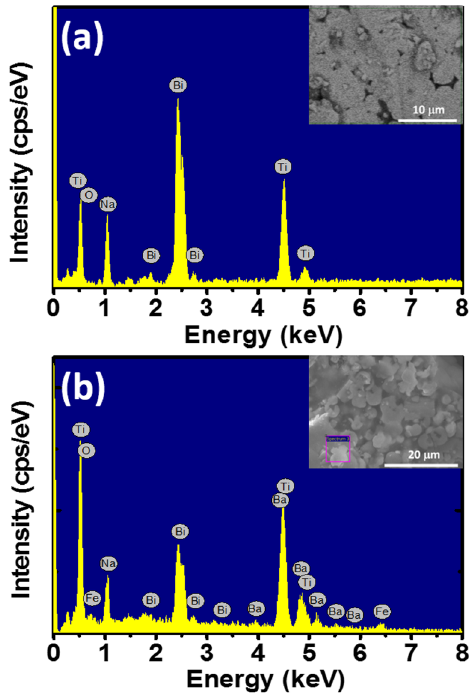
Figure 1. The EDS spectral of (a) pure Na 0.5 Bi 0.5 TiO 3 materials, and (b) BaFeO 3− δ -modified Na 0.5 Bi 0.5 TiO 3 materials with 5 mol% BaFeO 3−δ as solid solution. The inset of each figure shown the selected area for composition characterization.